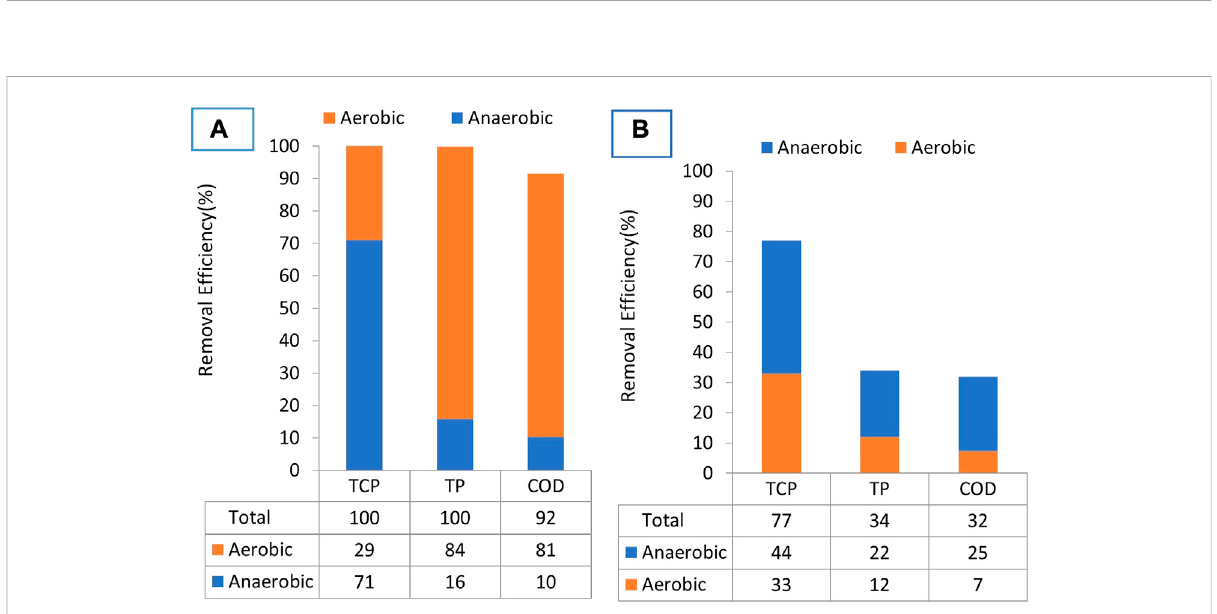
FIGURE 8 summarizes the effect of the sequence of anaerobic and aerobic conditions on SBR-RBB. (A) Average removal of TCP, TP, and COD in the anaerobic and Aerobic sequence. (B) Average removal of TCP, TP, and COD in the aerobic and Anaerobic